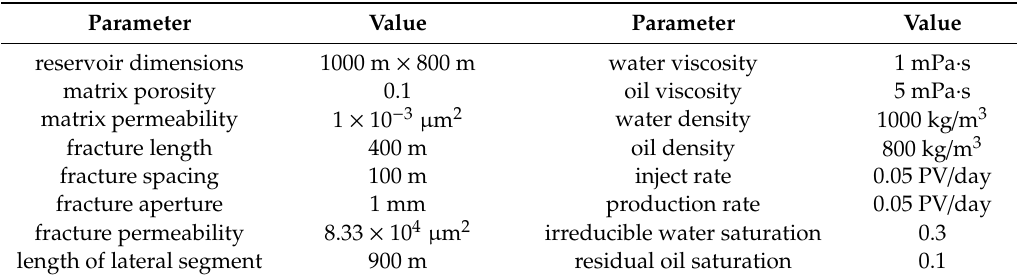
Figure 5. Delaunay triangulation of the water-injection model. Table 1. Rock and fluid properties for the staggered five spot water-injection model. Parameter